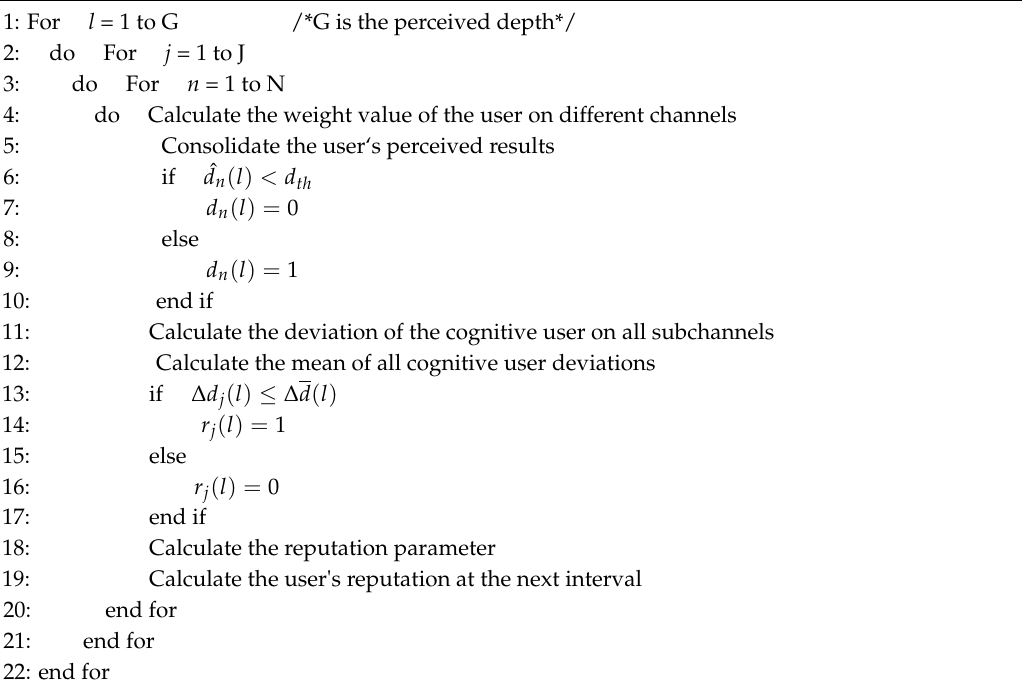
Algorithm Malicious user identification algorithm under multi-channel cooperative